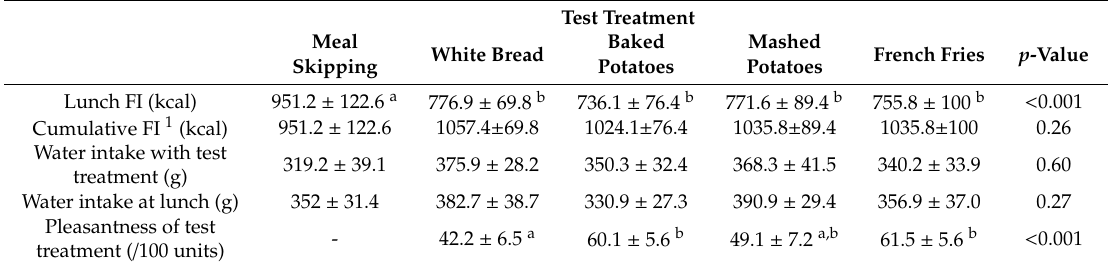
Table 3. E ff ect of treatment on food intake (FI), water intake, and pleasantness of test